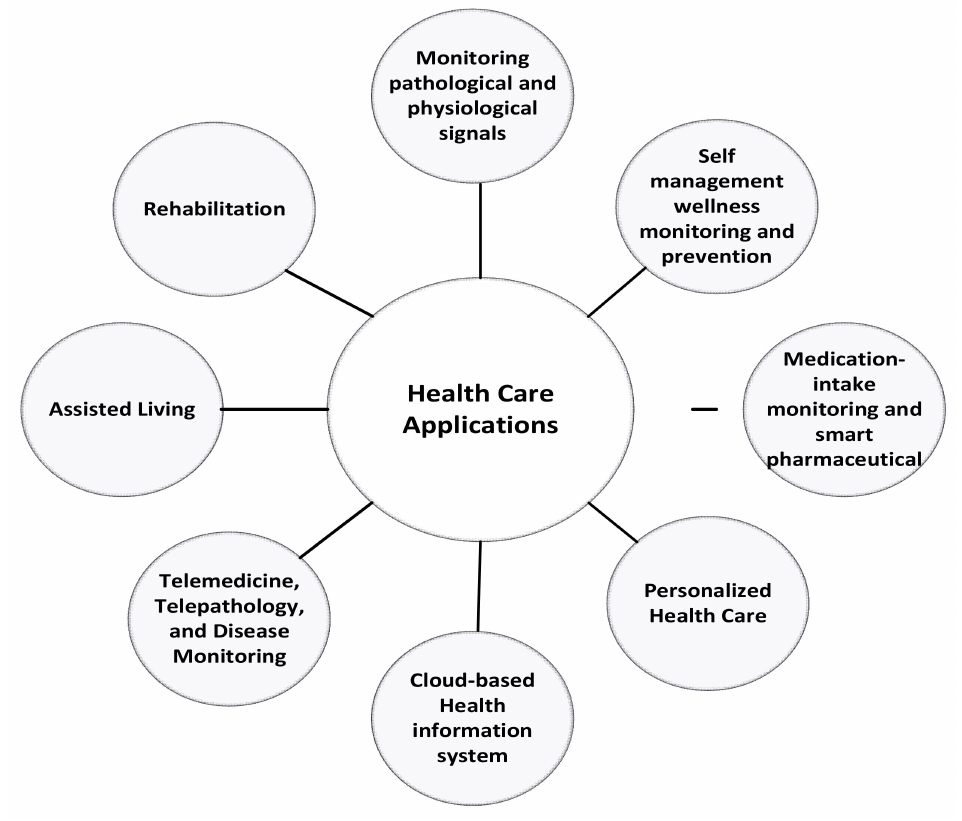
Figure 5. Healthcare applications of